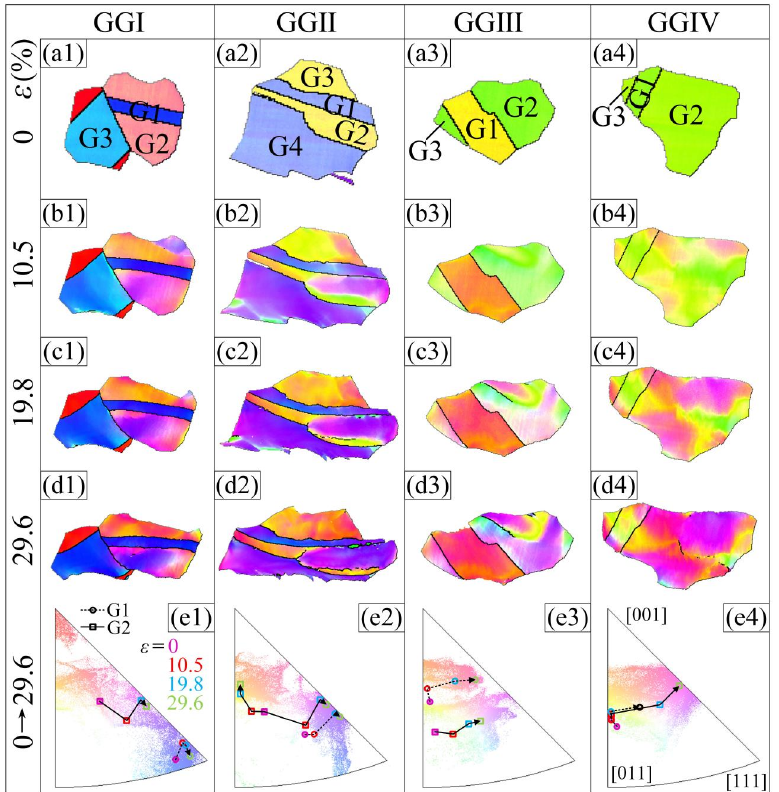
Figure 4. ( a1 – a4 ) OIM of grain groups GG Ⅰ ~GG Ⅳ at strain values of 0. ( b1 – b4 ) OIM of grain groups GG Ⅰ ~GG Ⅳ at strain values of 10.5%. ( c1 – c4 ) OIM of grain groups GG Ⅰ ~GG Ⅳ at strain values of GGI~GGIV at strain values of 10.5%. ( c1 – c4 ) OIM of grain groups GGI~GGIV at strain values of 19.8%. ( d1 – d4 ) OIM of grain groups GG Ⅰ ~GG Ⅳ at strain values of and 29.6%. ( e1 – e4 ) Inverse pole 19.8%. ( d1 – d4 ) OIM of grain groups GGI~GGIV at strain values of and 29.6%. ( e1 – e4 ) Inverse